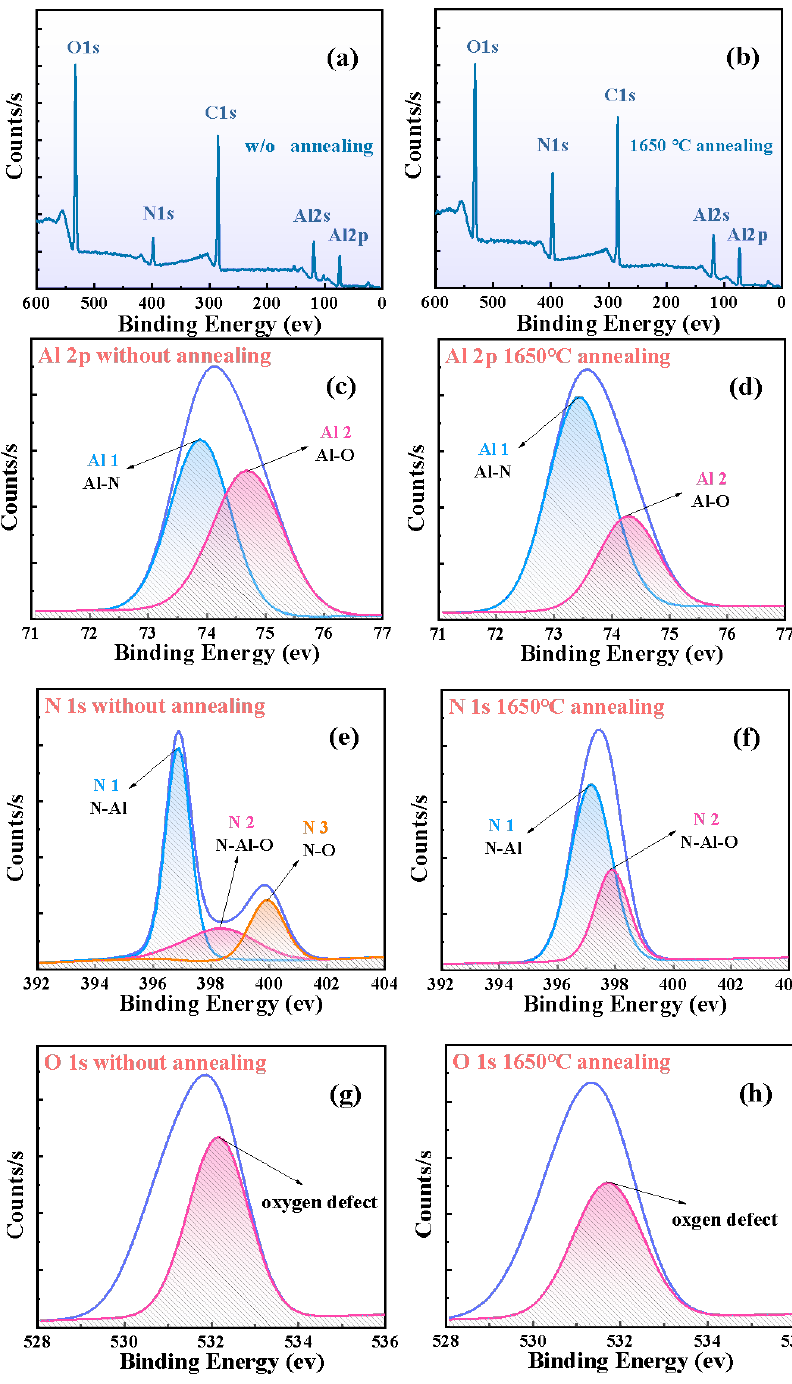
Figure 4. The XPS high-resolution scans for the non-polar film ( a ) without annealing and ( b ) with annealing at 1650 °C. The subpeak spectra of ( c ) Al 2p, ( e ) N 1s and ( g ) O 1s peaks on the surface of the non-polar film without annealing, and ( d ) Al 2p, ( f ) N 1s and ( h ) O 1s peaks with annealing at 1650 °C.